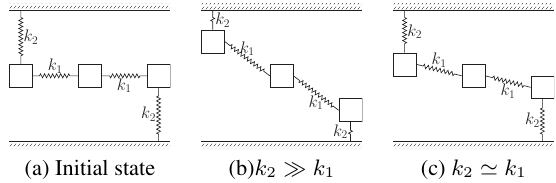
Figure 4: The mechanical system which can be interpreted